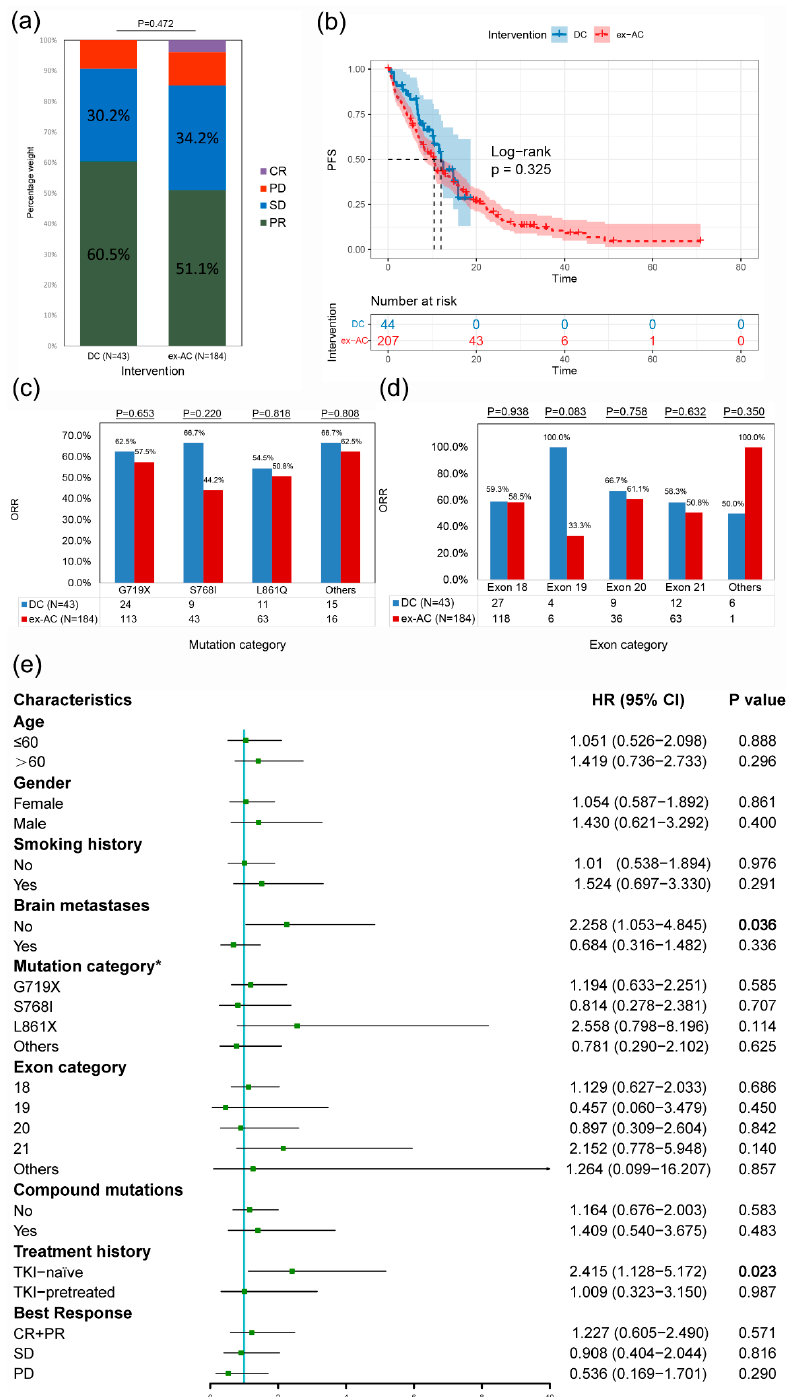
Figure 3. Comprehensive comparison between the DC and the ex-AC before PSM. Stacked histogram of treatment responses ( a ), Kaplan-Meier curves ( b ), ORRs of different mutation categories ( c ), ORRs of different exon categories ( d ), and subgroup analysis of PFS ( e ) of the DC and the ex-AC before PSM. ORR, objective response rate; PFS, progression-free survival; DC, dacomitinib cohort; AC, afatinib cohort; ex-AC, external afatinib cohort; CR, complete response; PR, partial response; SD, stable disease; PD, progressive disease; HR, hazard ratio; CI, confidence interval; TKI, tyrosine kinase inhibitor; PSM, propensity score matching. * Uncommon mutation categories overlap with compound mutations, so each patient might belong to more than one